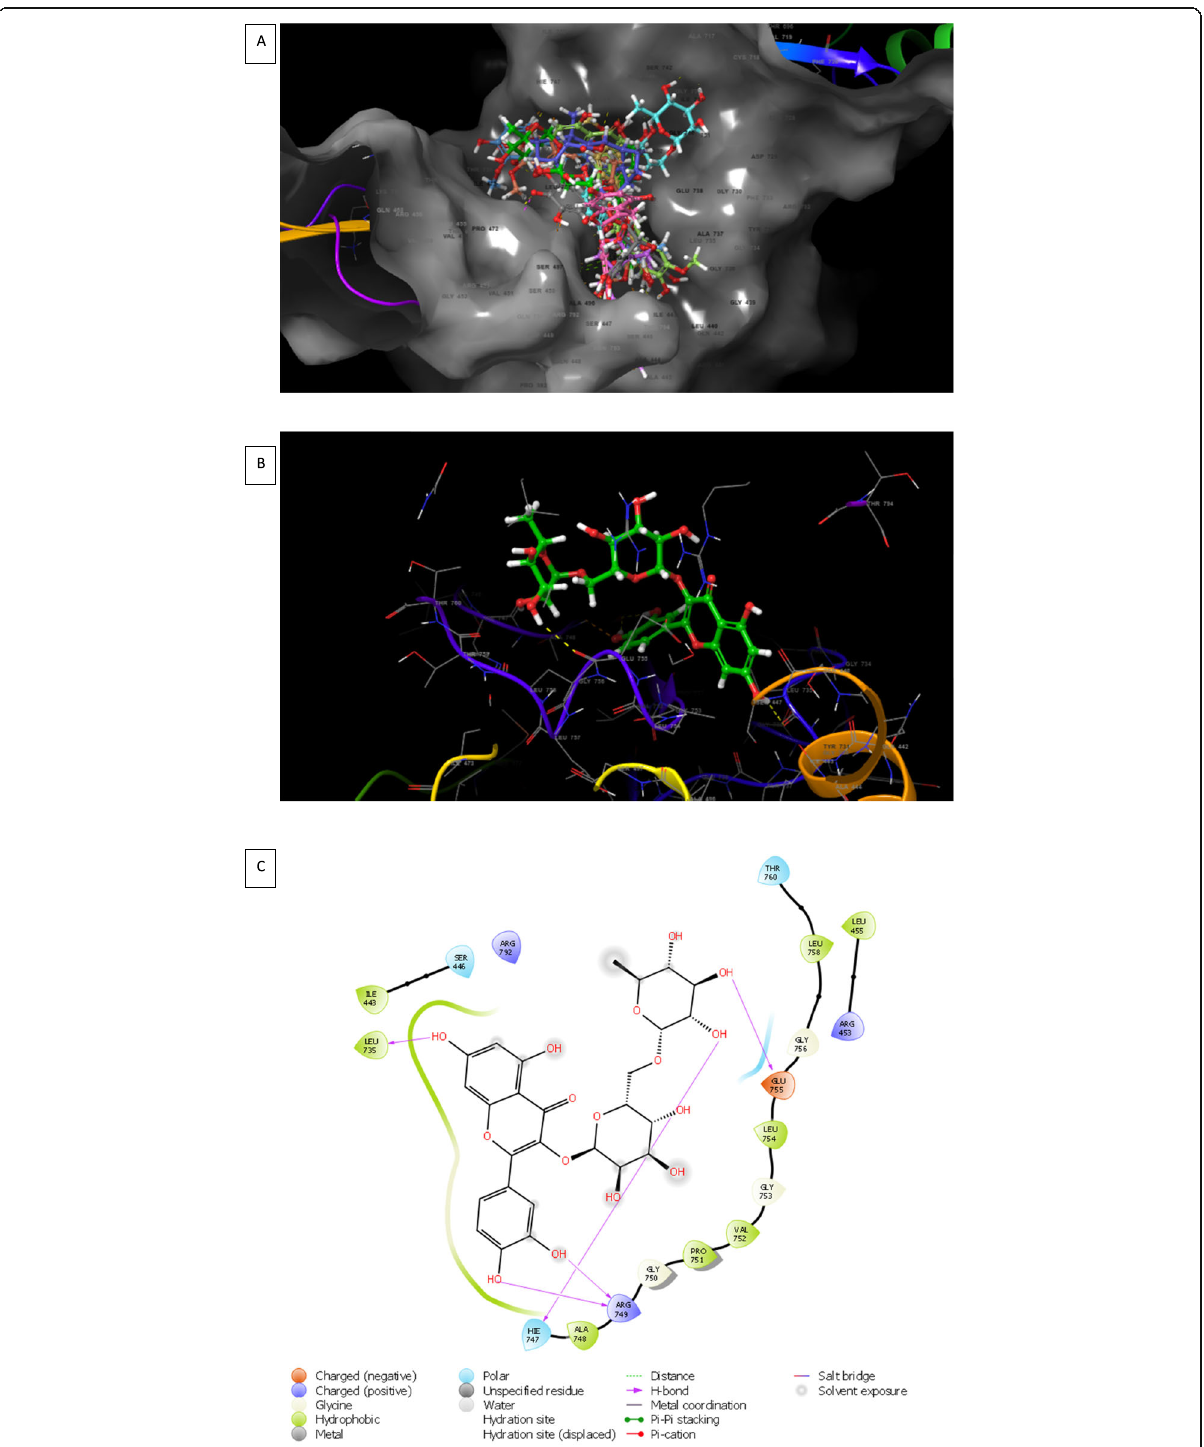
Fig. 4 a The probable binding mode of all ligands to ALDH18A1. b Interaction diagram of rutin ligand with ALDH18A1 protein: the yellow dotted lines in 3D figure indicates the hydrogen bond between the ligand and protein receptor. c Two-dimensional interaction diagram indicates the rutin interaction with ALDH18A1, one hydrogen bond is between the ligand and amino acid 735 leucine, two hydrogen bond with 749 aspargine, 755 glutamic acid, and 747 histidine residue in receptor of